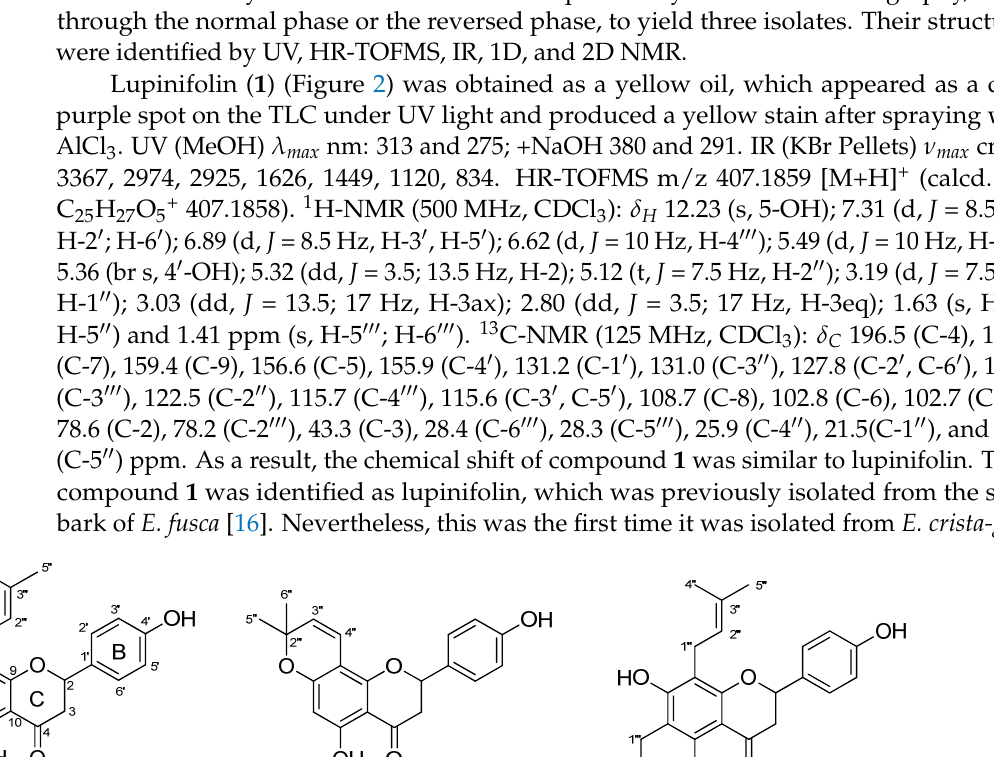
Table 1. The global descriptive parameters (in eV) of 1 – 3 and standard compounds at the B3LYP/6-31+G (2d,2p) level of